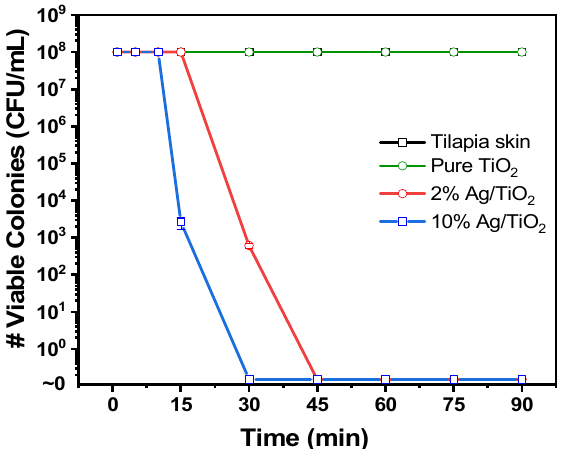
Figure 5. Kill time kinetics for tilapia skin impregnated with mixed oxides: negative control (curve in black), 10% Ag/TiO 2 (curve in blue), 2% Ag/TiO 2 (curve in red), and 0% Ag/TiO 2 (curve in